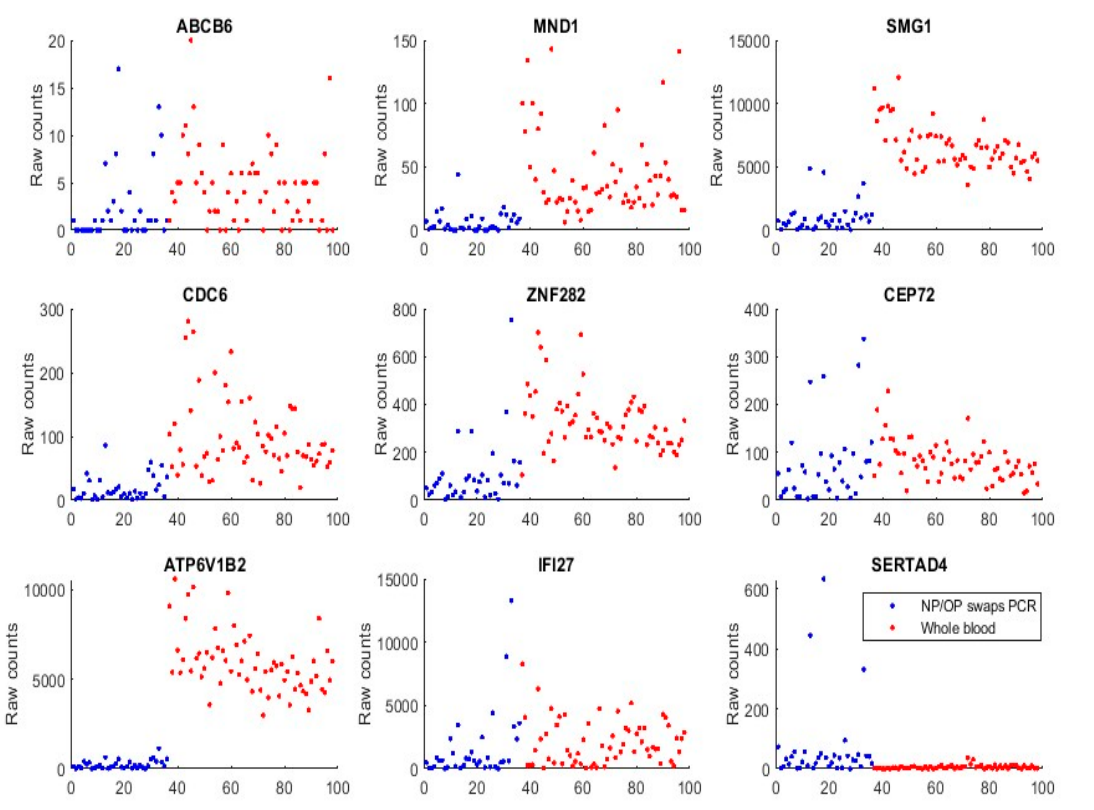
Figure 3. Gene expression raw counts from COVID-19 positives. The red-colored dots represent patients from GSE152641 whole blood samples. The blue dots represent patients from GSE166530 NP/OP PCR swab samples.